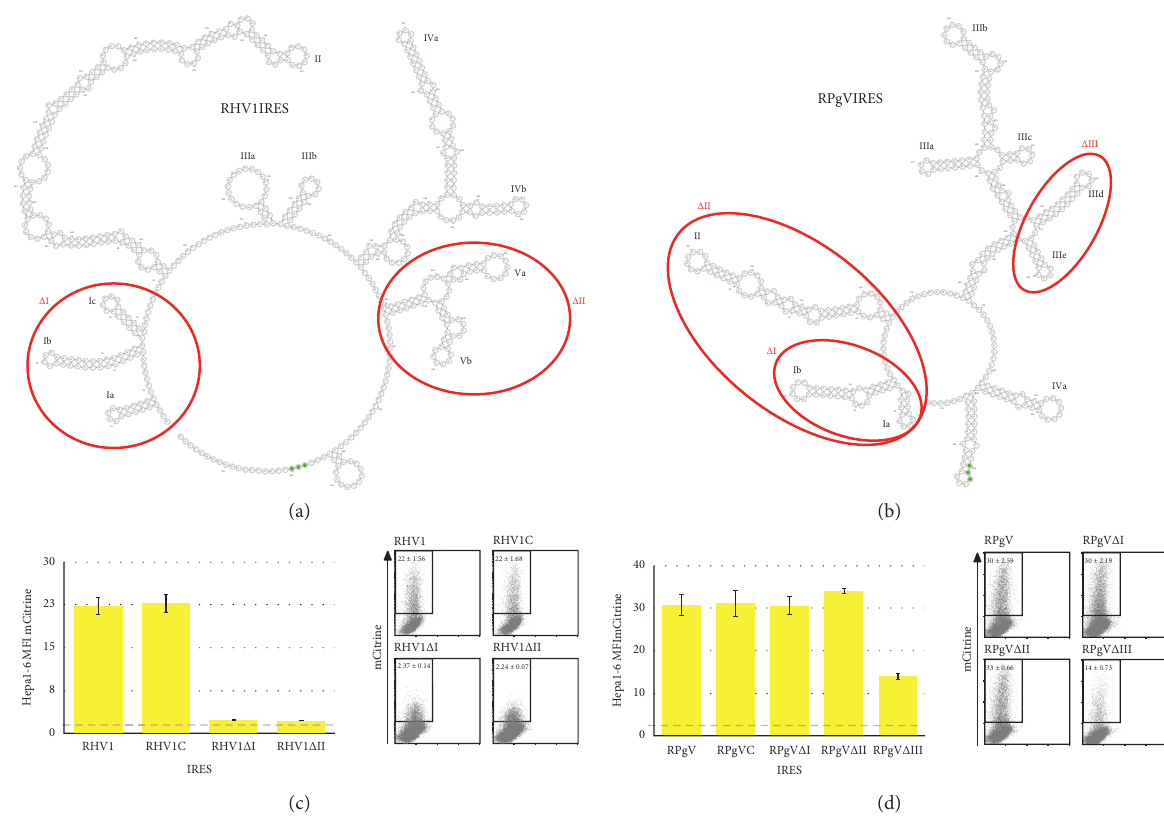
Figure 3: Deletions to RHV1 and RPgV 5 ′ UTR abrogate IRES translation. Predicted RNA secondary structure of RHV1 (a) and RPgV (b). Red circles indicate areas deleted from plasmids. Hepa1-6 cells were transfected with RHV1 (c) and RPgV (d) plasmids. Cells were harvested and analysed by flow cytometry at 48h.p.t. Bar graphs show MFI for mCitrine ( n ≥ 8, mean ± SEM of at least three independent experiments) and representative FACS plots on the right of each graph; numbers represent the MFI (mean ± SEM). The dashed line represents the fluorescent output of the control plasmid containing a scrambled sequence in place of the viral 5 ′